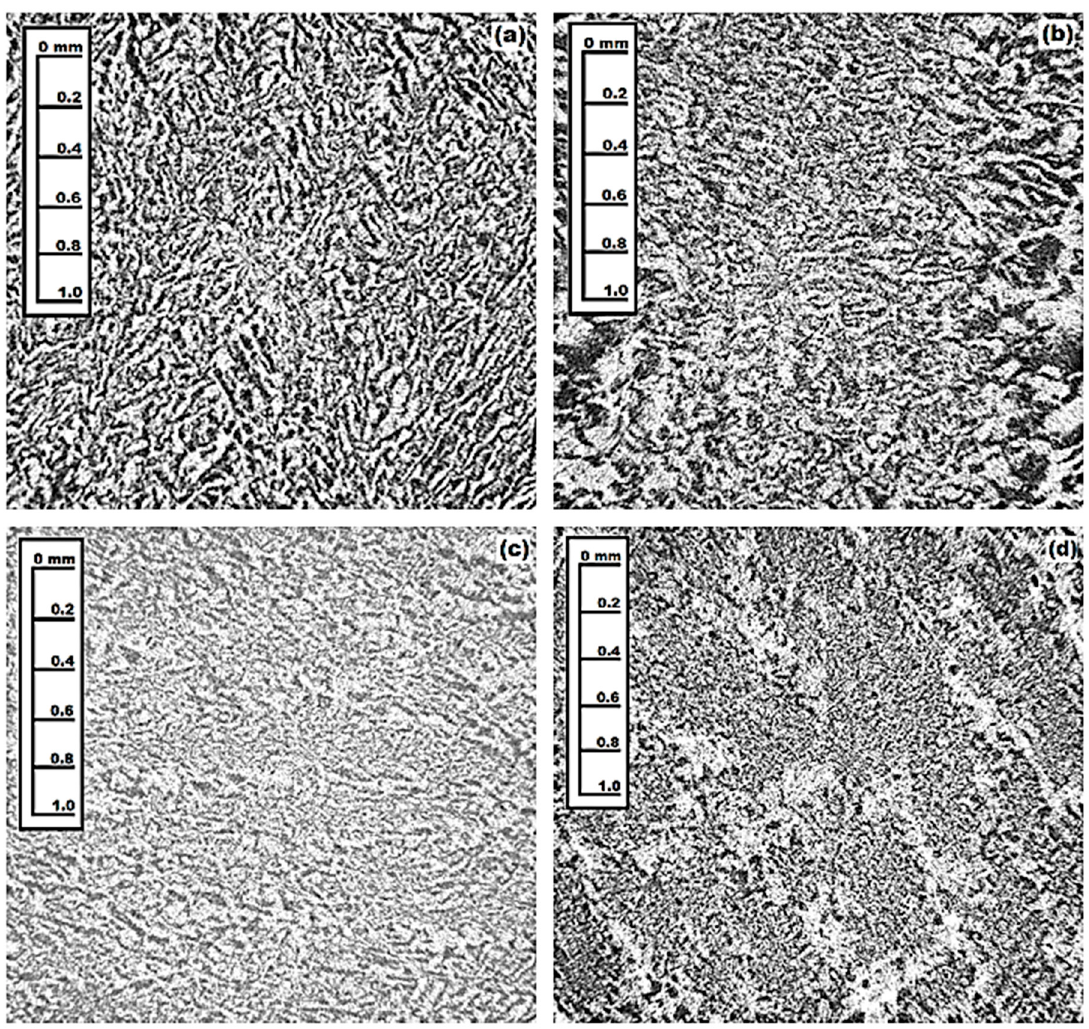
Figure 4. X-ray microtomography of the (Al 2 O 3 -YAG):Ce eutectic: garnet (white) and sapphire (gray) phases distribution for samples 2 ( a ), 3 ( b ), 4 ( c ), and 5 ( d ).